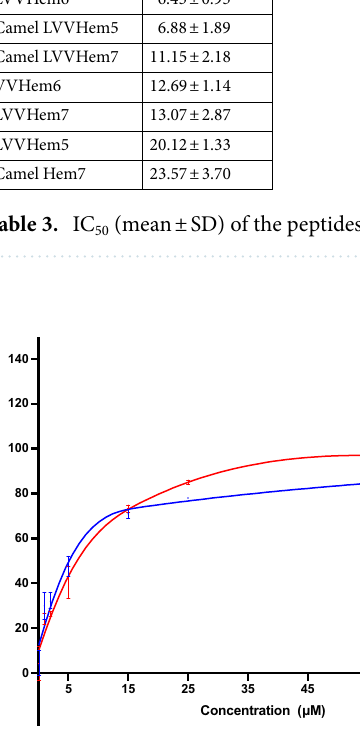
Figure 1. Dose–response curves of camel LVVHem6 and LVVHem6 against ACE1. The data are represented as the mean ± SD of three independent